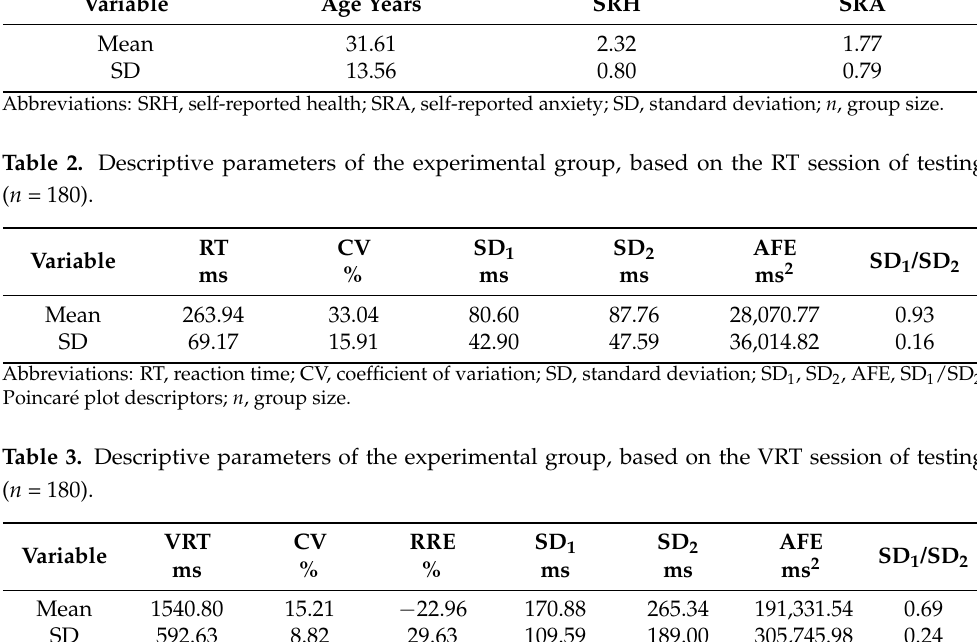
Table 1. Descriptive parameters of the experimental group, based on the questionnaire answers ( n = 180). Variable